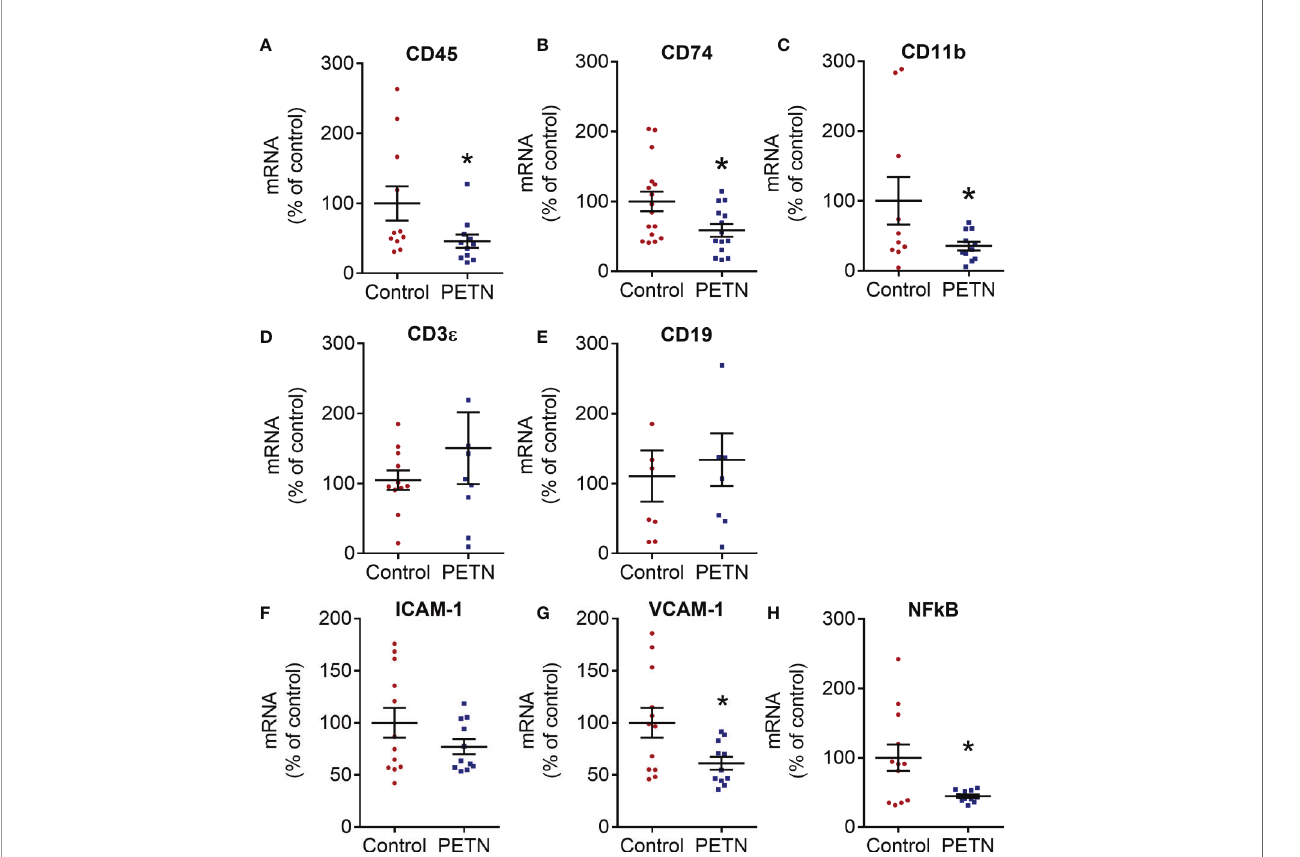
FIGURE 7 | Maternal pentaerythritol tetranitrate (PETN) treatment leads to reduction in macrophage in fi ltration in kidney of female offspring. Parental spontaneously hypertensive rats (SHR) were treated with or without PETN (50 mg/kg/day) during pregnancy and lactation periods. Different cell surface markers of antigen presenting cells were measured by the gene expression of cluster of differentiation (CD) 74 (A) , CD 45 (B) , CD 11B (C) , CD3 ϵ (D) , and CE19 (E) in the kidney of 16- week-old female offspring. Proin fl ammatory gene expression of intercellular adhesion molecule-1 (ICAM-1) (F) , vascular cell adhesion protein 1 (VCAM-1) (G) and nuclear factor kappa-light-chain-enhancer of activated B cells p105 subunit (NF- k B) (H) in the kidney of 16-week-old female offspring were measured. RNA polymerase II was used as reference gene for qPCR. Column represents mean ± SEM, n=8 − 12. Student ’ s t test was used for comparison of PETN group with control group. * P < 0.05, vs. control